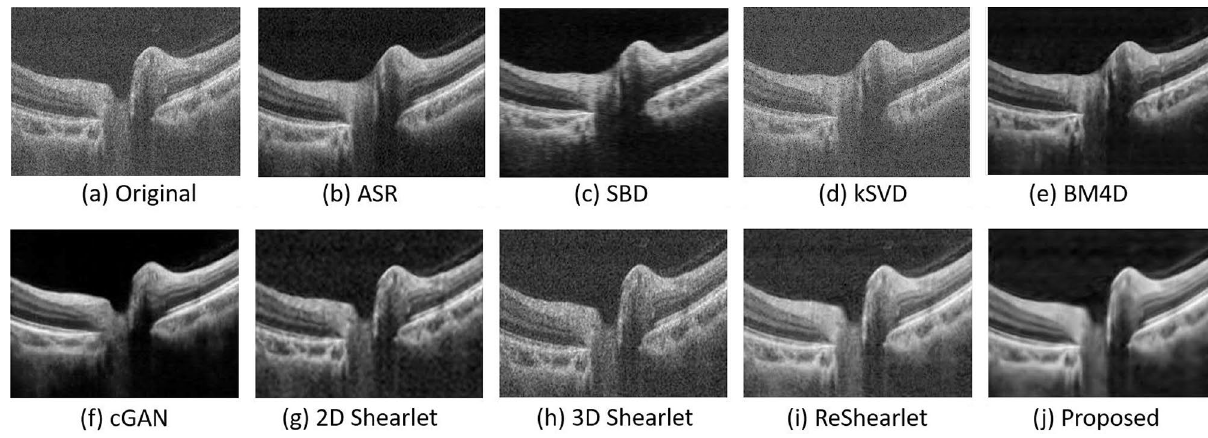
Figure 9. Sample OCT images from diseased eyes from Optovue machine by our adaptive-SIN and other 8 algorithms for the performance evaluation. The proposed approach better removes the noise and preserves the image micro-structures, and also exhibit better image